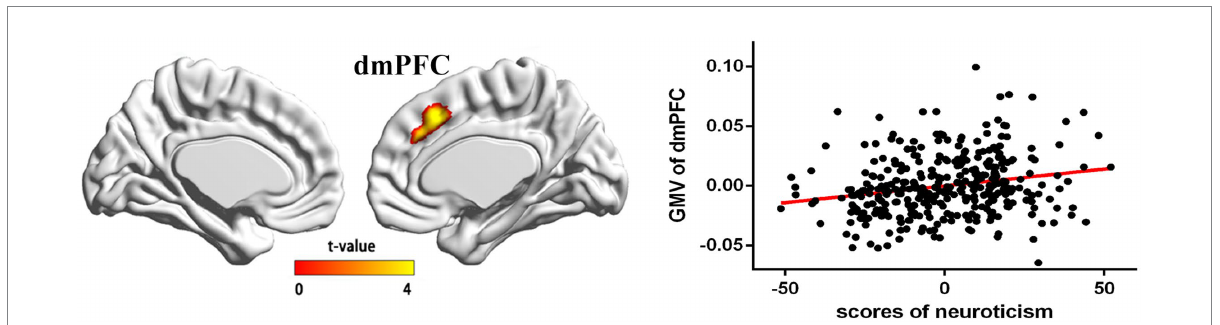
FIGURE 1 The regions of positive association between gray matter volume (GMV) and neuroticism (the results are p < 0.05, corrected) and the partial correlations (control age, sex, and whole brain gray volume) in a scatterplot between neuroticism and mean GMV within a significant cluster mainly included areas in the dmPFC ( x = 5, y = 22, and z = 44).